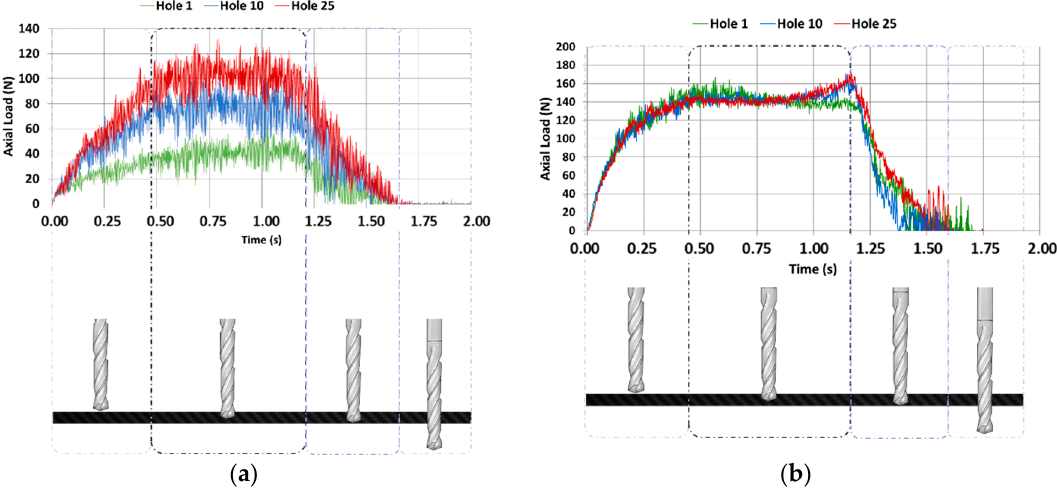
Figure 15. ( a ) Axial force with respect to the time applied to the drilling of CFRP plate; ( b ) axial force with respect to the time applied to the drilling of UNS A97075 plate.